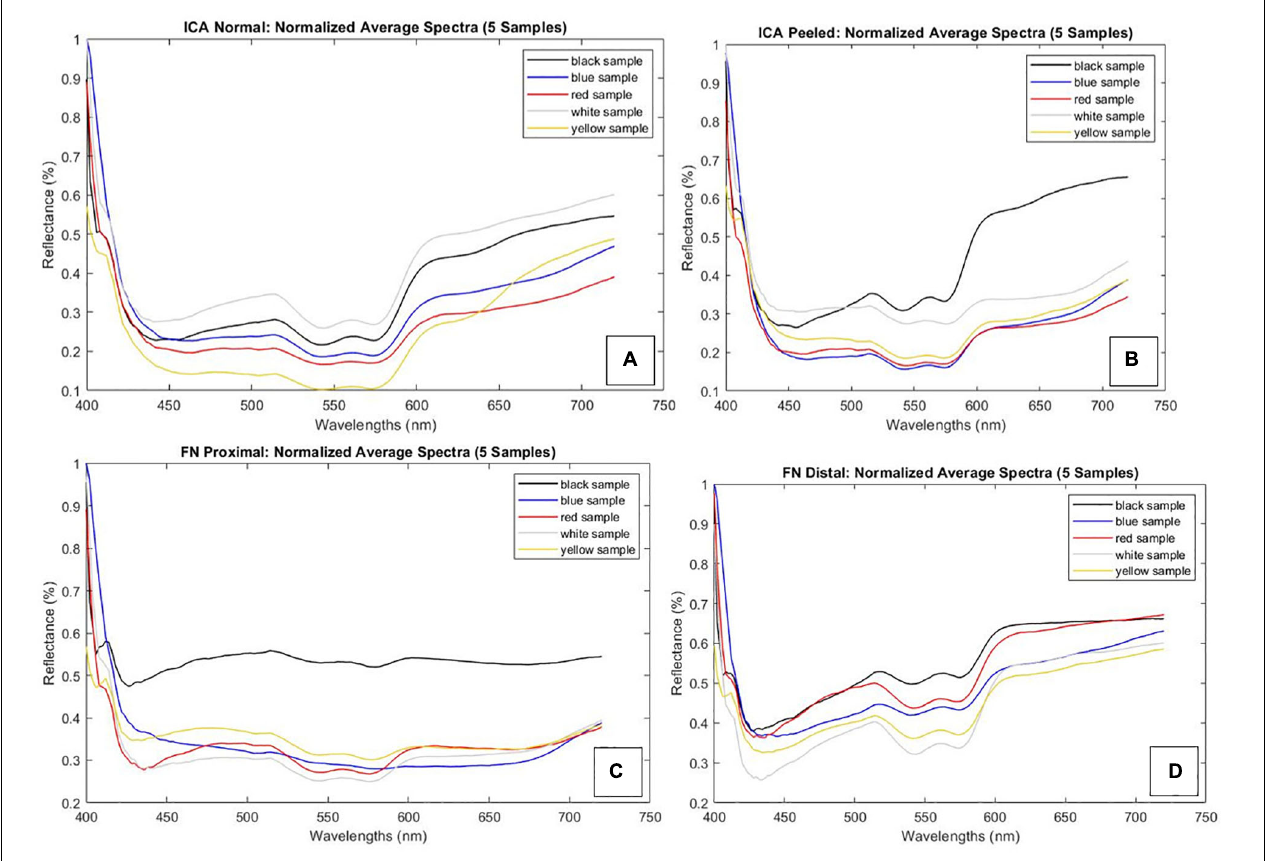
FIGURE 2 | Normalized spectral signatures of studied tissue types and a mention of sample-specific anomalies. Graph corresponding colors (black, blue, red, white, and yellow) are used to identify the set of samples. Each set constitutes ICA peeled, ICA normal, FN distal, and FN proximal samples. (A) ICA normal samples. Tunica adventitia overlaps on yellow samples with lower reflectance. (B) ICA peeled samples. Plaque formation on black samples with notably higher reflectance values. (C) FN proximal samples. Unknown discoloration on black samples with a flat curve. (D) FN distal samples. Abbreviations: ICA, internal carotid artery; FN, facial